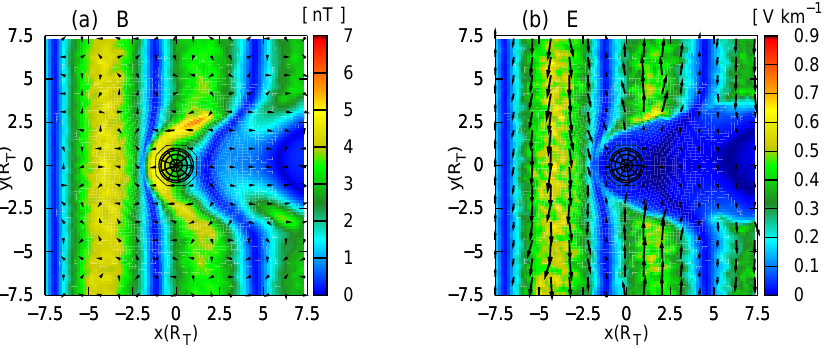
Fig. 3. Run #2 : Titan’s plasma environment when the satellite is exposed to a periodic distortion according to eqs. (8) and (9). The period T = 2 π/ω of the distortion is T = 1000 δt , where 1333 δt correspond to the duration in which the magnetospheric plasma would pass through the simulation box one time. The plot shows a snapshot of the electromagnetic fields in Titan’s orbital plane.